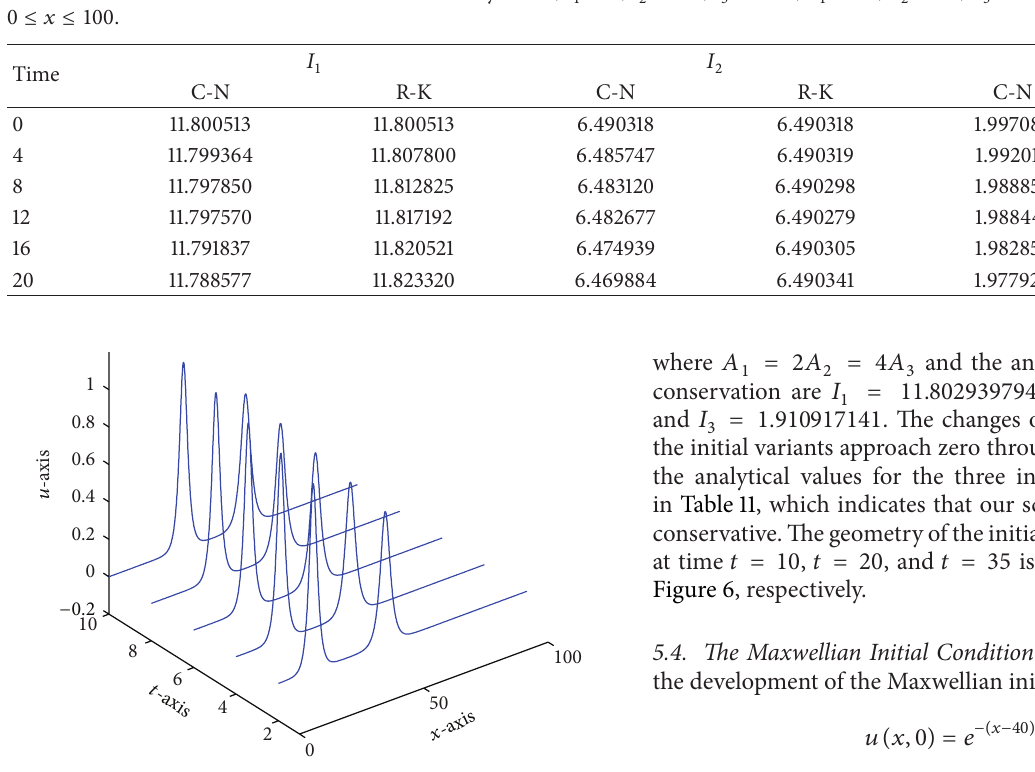
Figure 5: Interaction of two solitons at times from 𝑡 = 2, 4, 6, 8,10 for 𝑐 1 = 1 , 𝑐 2 = 0.5 , 𝑥 1 = 10 , 𝑥 2 = 40 , and 0 ≤ 𝑥 ≤ 100